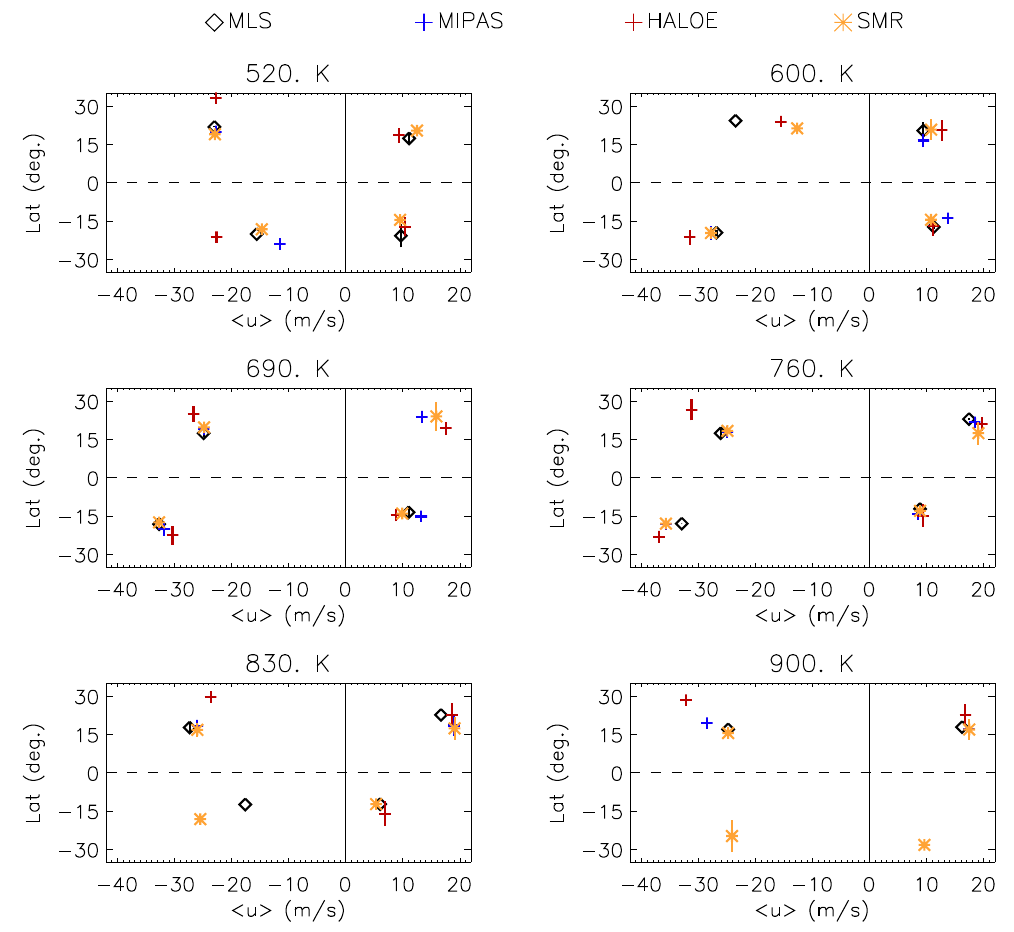
Fig. 8. Correlation between the multiannual mean winter (DJF NH, JJA SH) position of the subtropical barrier and the zonal mean zonal wind component measured at Singapore at different potential temperature levels, for the MLS (black), MIPAS (blue), SMR (yellow), and HALOE (red) instruments. Data are missing in the plots when the multiannual average at one specific level is calculated over less then 2 data points.